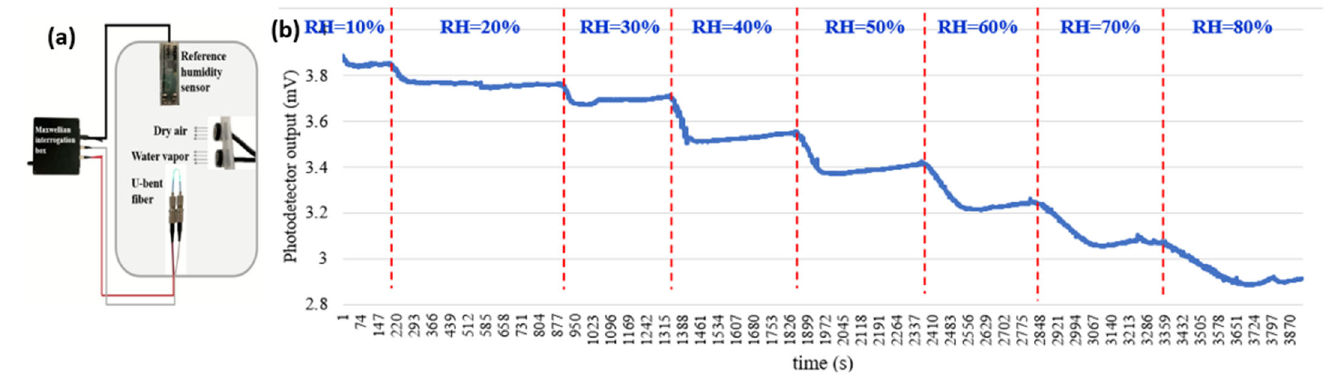
Figure 7. ( a ) Experimental setup to measure the response of the probes to the humidity. ( b ) A typical response of the probes to the humidity.